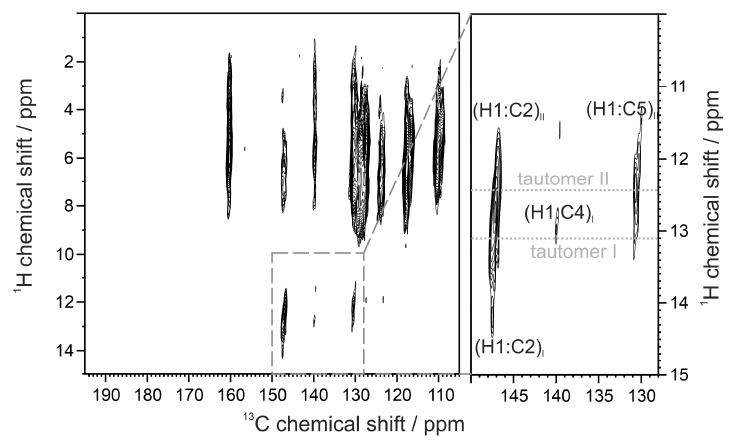
Figure 4. 1 H- 13 C CP-MAS correlation spectrum of compound 1b . Right block shows magnified view of the selected area in the correlation spectrum.